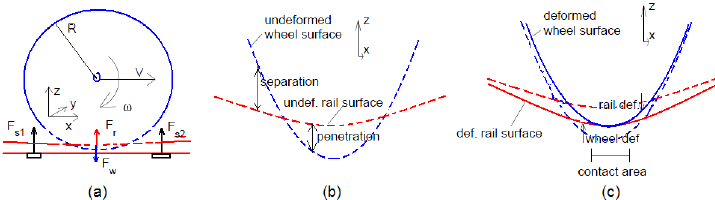
Figure 1. Geometry of contact problems for railway applications [34]: (a) the overall geometry, (b) undeformed state, (c) deformed state.